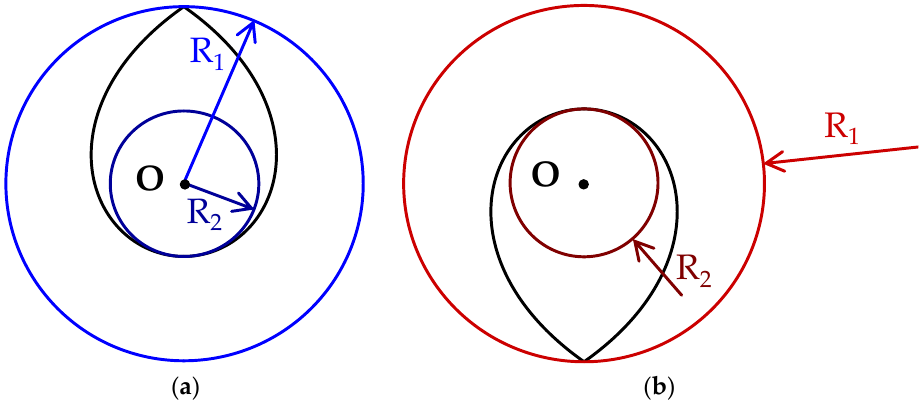
Figure 5. The drop ( a ) at gauge pressure of H 1 min , and bubble ( b ) at gauge pressure of H 2 max with the drawn cross sections of the spheres that result from Equation (33); the hydrostatic pressure in Equation (33) is determined at the tips, bottom, or apex.